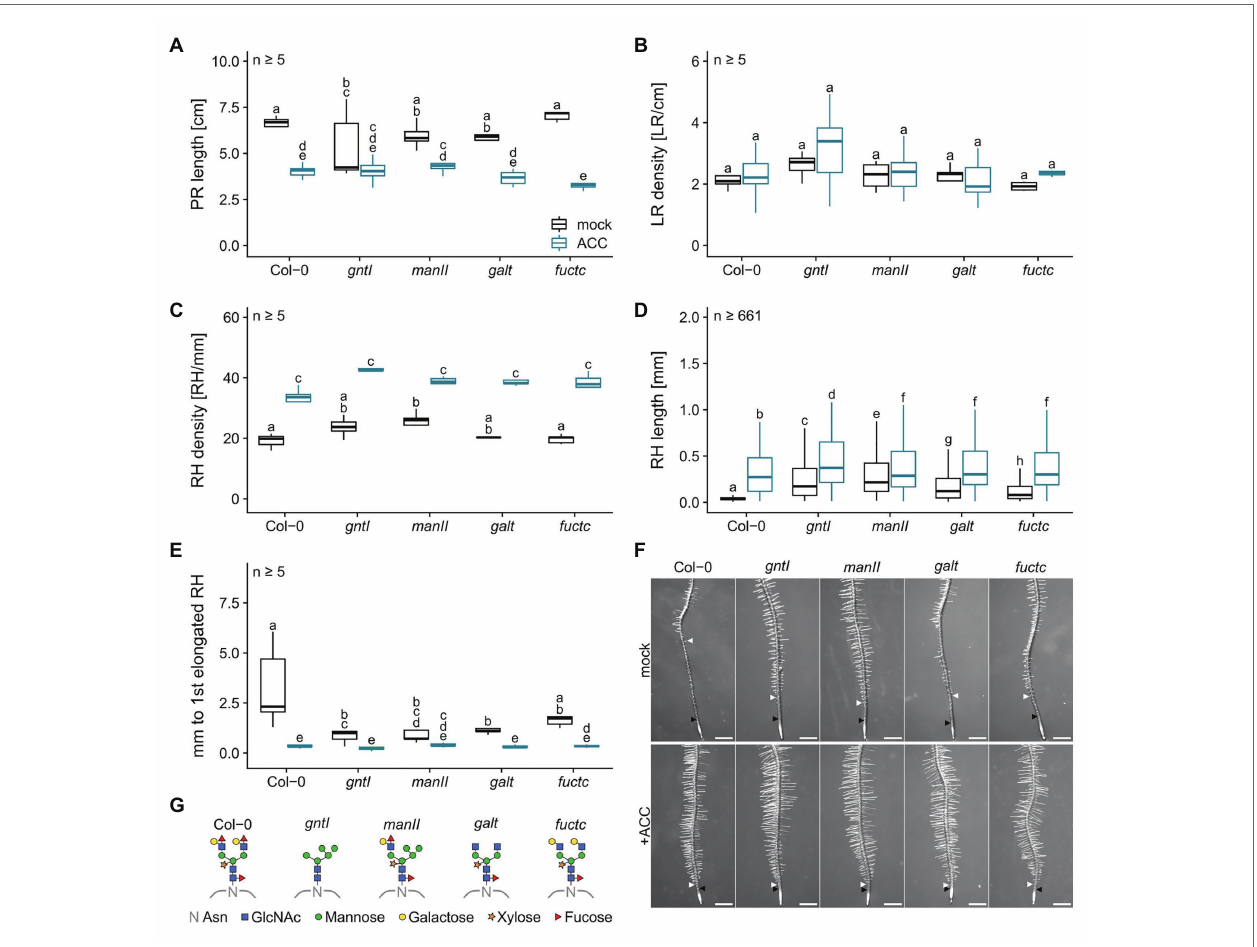
FIGURE 2 | Roots compromised in complex N-glycan modification respond wild type-like to ACC. (A) Primary root length, (B) lateral root density, (C) root hair density, (D) root hair length, and (E) distance between first general and first partially elongated root hair of N-glycosylation mutants and wild-type plants cultivated for 8 days on mock (black boxes) or 100 nM ACC (blue boxes). Letters indicate significant differences between groups [ p ≤ 0.05; (A–C,E) two-way ANOVA with Tukey post hoc test; (D) Kruskal-Wallis test, FDR corrected via Benjamini-Hochberg]. (F) Pictures of wild type (Col-0) and N-glycosylation mutant root tips. Black arrows indicate the first general root hair while white arrows point to the first partially elongated root hair. Scale bars: 500 μ m. (G) N-glycan structures of the mutants tested. PR, primary root; LR, lateral root; RH, root hair; Asn, Asparagine; GlcNAc,